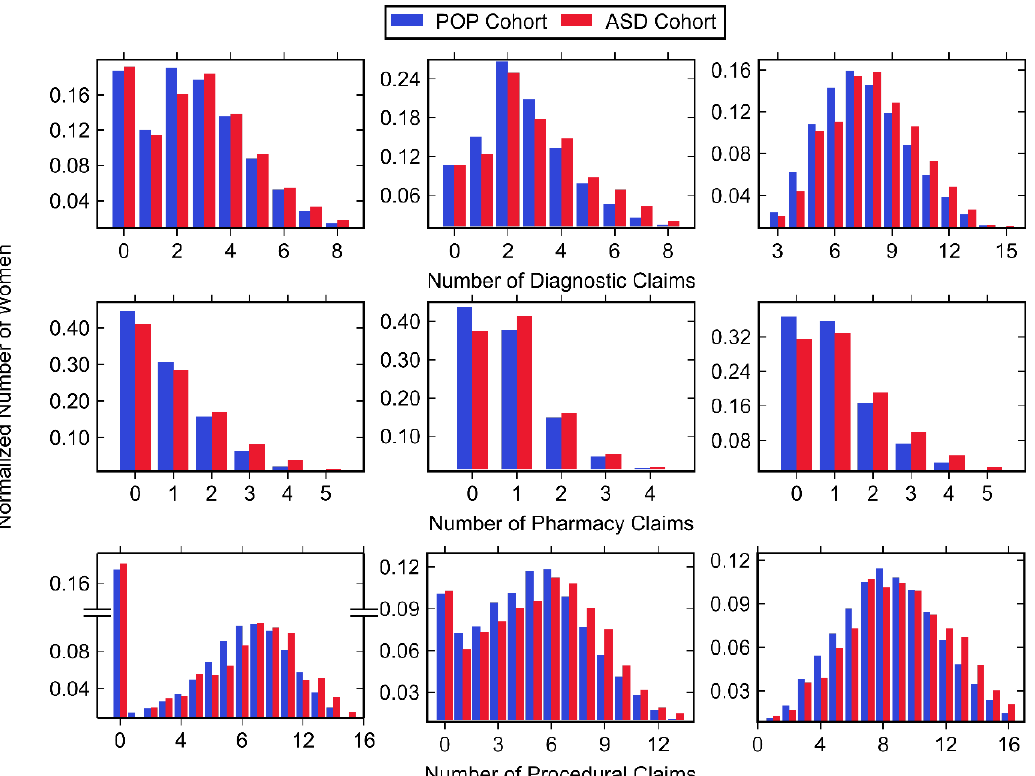
Figure 4. Histogram data of normalized number of women belonging to the POP and ASD cohorts (shown in blue and red, respectively) with any diagnostic (top row), pharmacy (middle row), and procedural (bottom row) claim during the first trimester (left column), second trimester (middle column), and third trimester (right column). Values associated with small cell sizes are not shown in order to be compliant with OptumLabs’ de-identification policy.